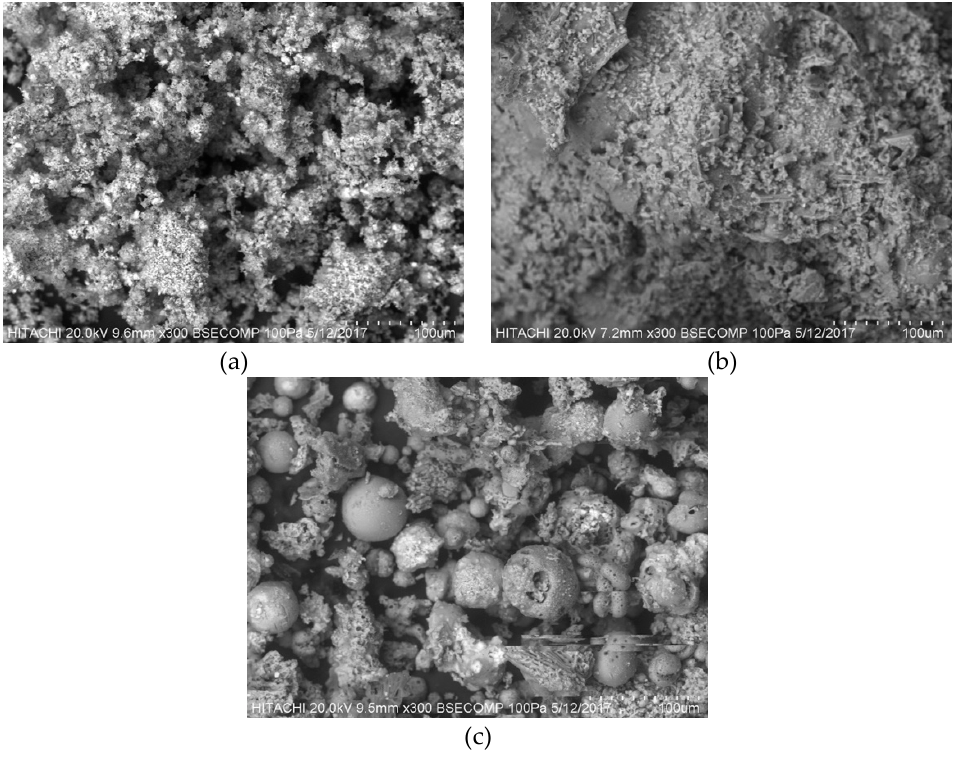
Figure 2. SEM images of ( a ) POMB-retained ash, ( b ) POMB bottom ash, and ( c ) POMC ash.